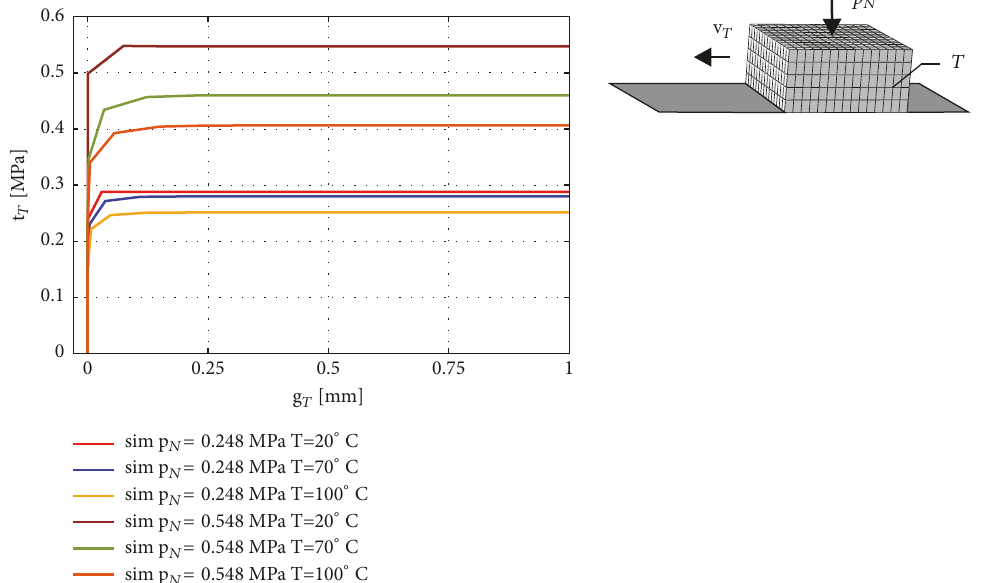
Figure 9: Tangential stresses in the rubber block simulation in dependency on temperature and normal pressure.